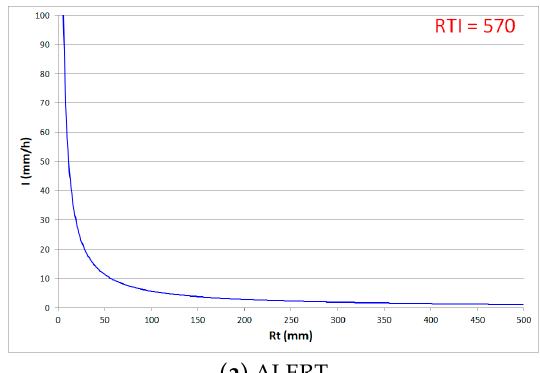
Figure 10. Estimation of rainfall triggering index (12 h): ( a ) ALERT; ( b ) WARNING; ( c ) EMERGENCY.